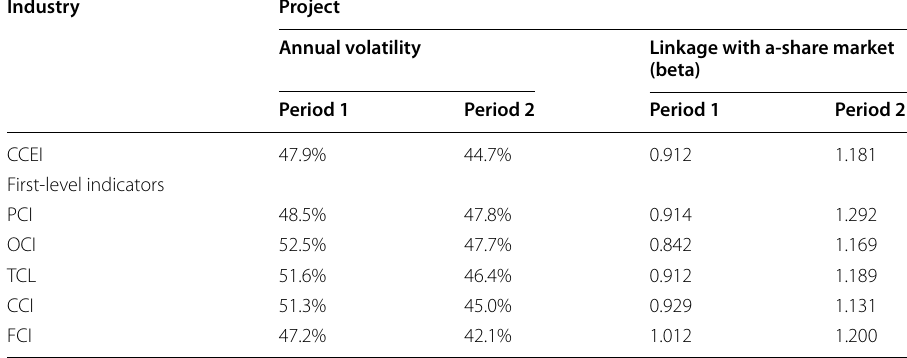
Table 9 Performance of listed companies